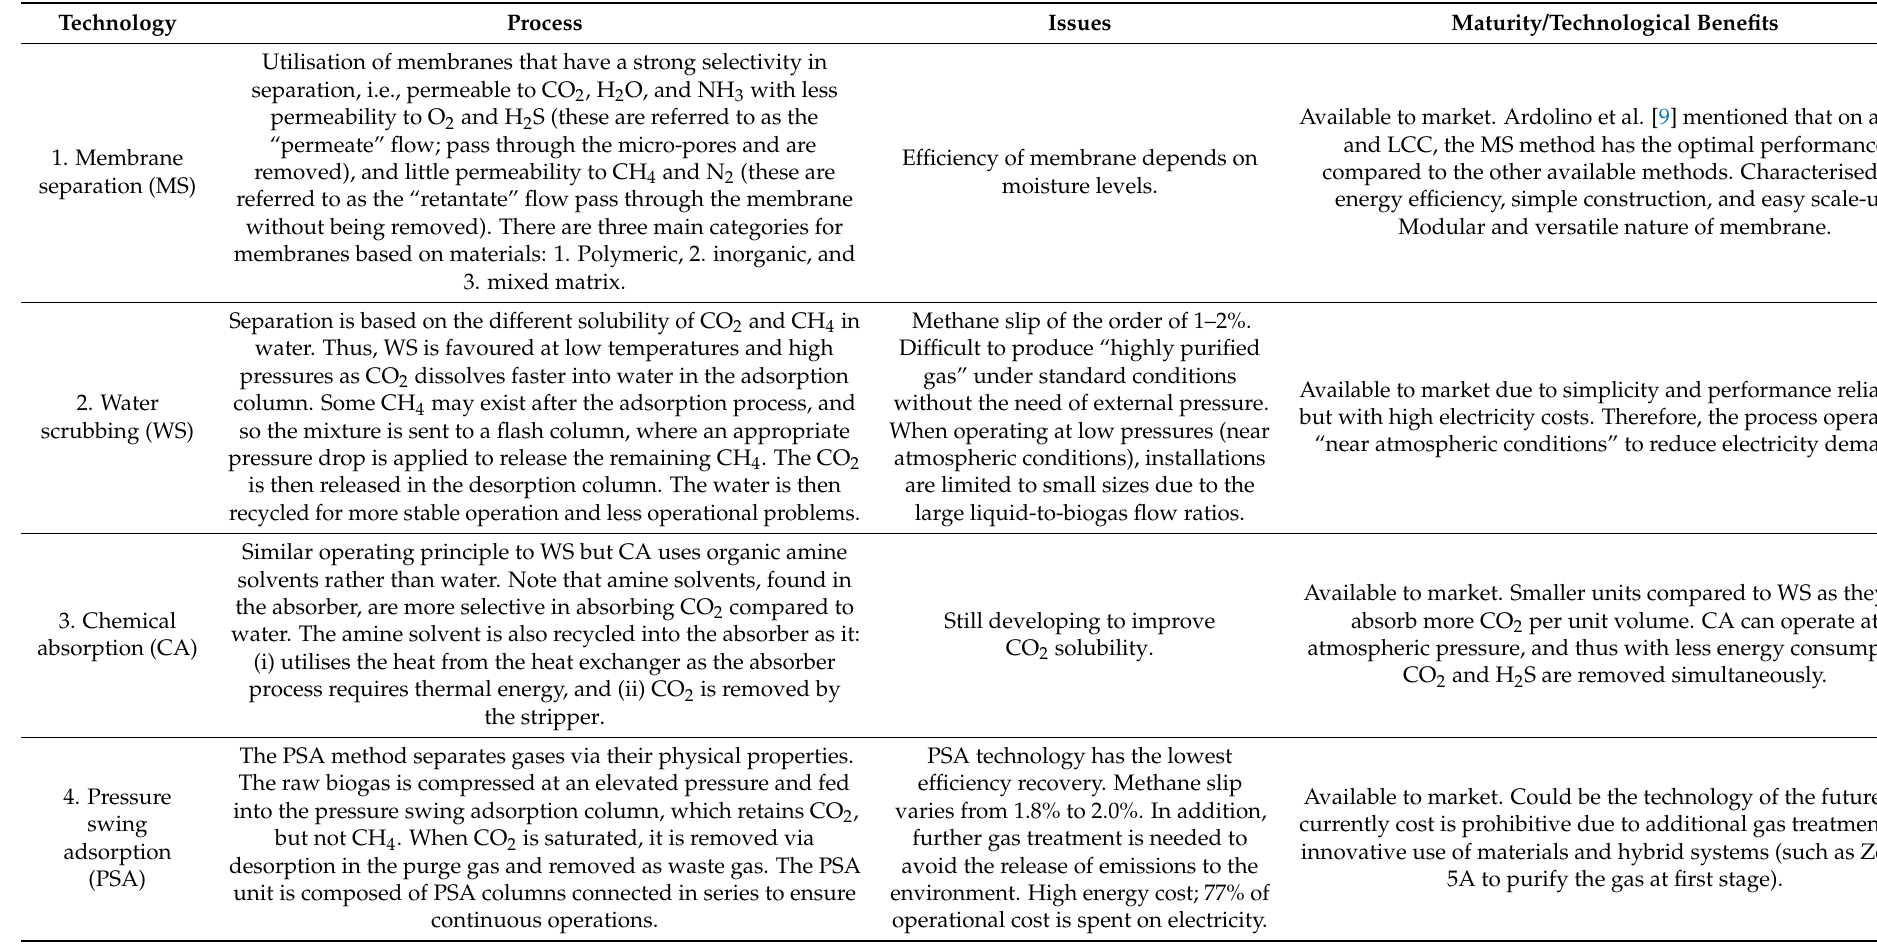
Table 5. Biogas to biomethane upgrading technologies: 1. membrane separation (MS), 2. water scrubbing (WS) 3. chemical absorption (CA), and 4. pressure